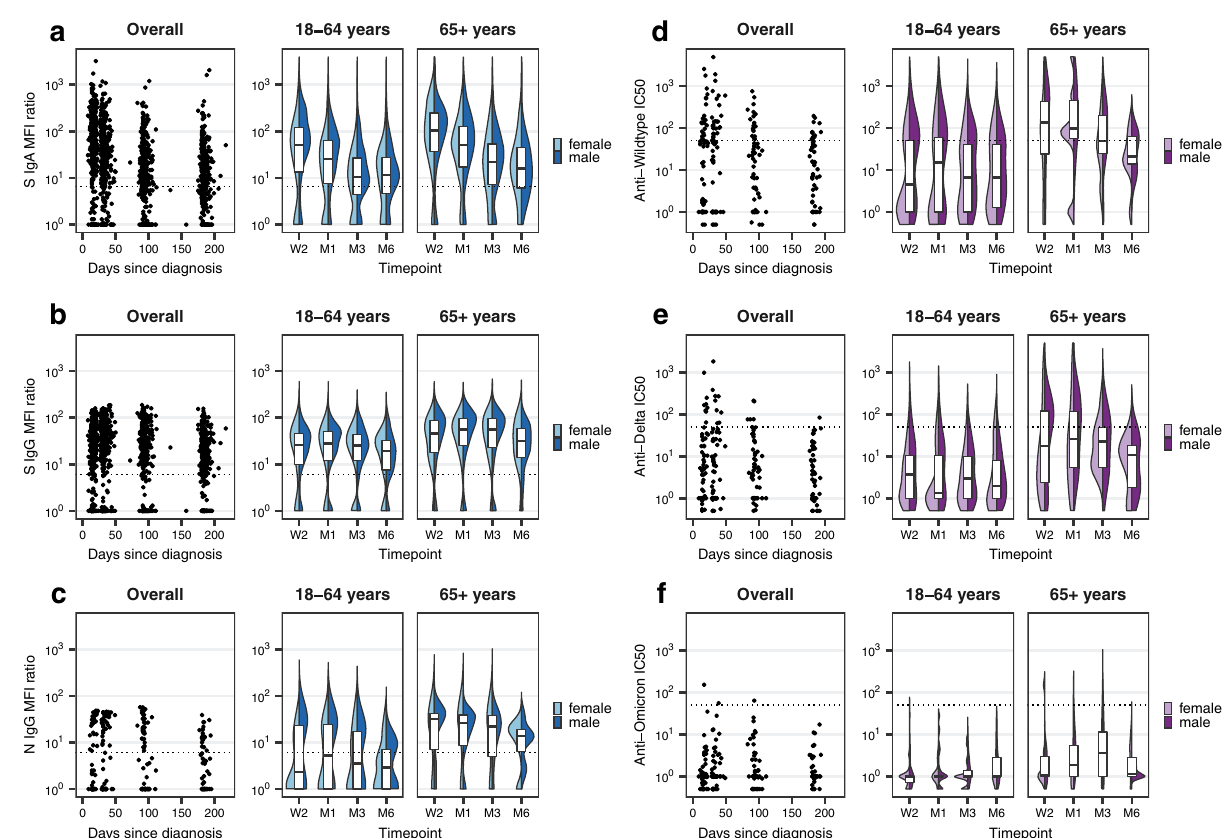
Fig. 2 | Anti-SARS-CoV-2 S IgA,S IgG,N IgG and neutralizingactivityovertime. a Anti-S IgA mean fl uorescence intensity (MFI) ratios measured by Luminex assay within the overall study population (total n =431; W2: n =403, M1: n =421, M3: n =418, M6: n =334), overall and strati fi ed by age groups and sex. Boxplots in panels a – f represent the median and interquartile range (IQR; whiskers: 1.5×IQR). Dotted lines in panels a – f indicate the limit of detection cutoffs (6.5 for IgA MFI ratios, 6.0 for IgG MFI ratios, and 50 for half maximal inhibitory concentrations (IC 50 ) for neutralizing activity). W2: two weeks, M1: one month, M3: three months, M6: six months after diagnosis. b Anti-S IgG MFI ratios within the overall study